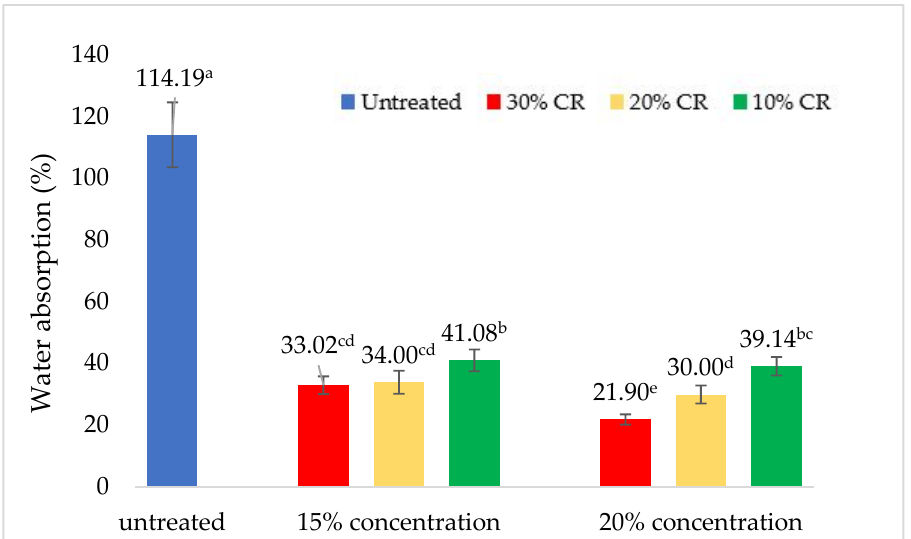
Figure 3. Water absorption of compreg oil palm inner wood. Note: Means followed by the same letter a, b, c, d, e is not significantly different at p ≤ 0.05.